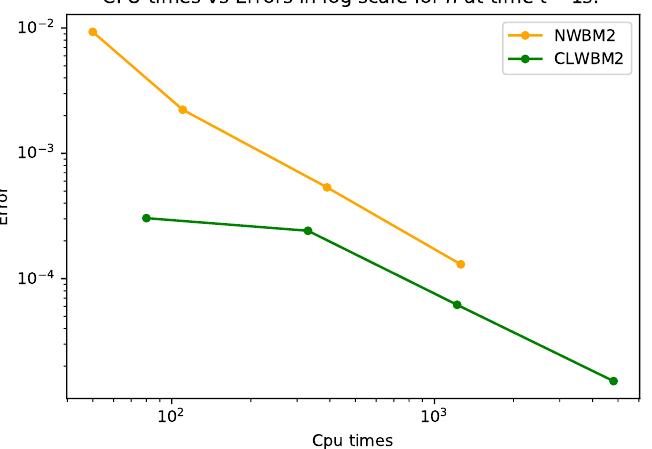
Figure 8. Test 3.3. Errors in L 1 -norm with respect to the reference solution versus CPU times in milliseconds for the NWBM2 and CLWBM2 at time t = 1